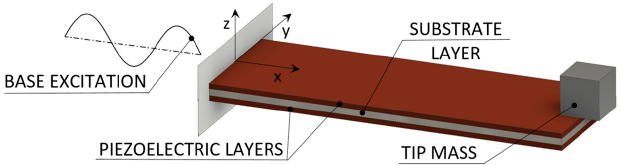
Figure 6. Piezoelectric bimorph vibration EH device [32].